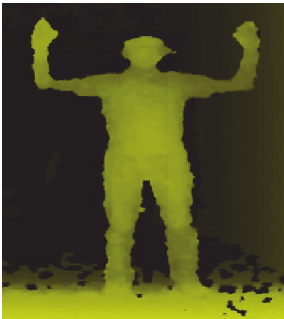
Figure 1: A user makes a surrender pose in front of a